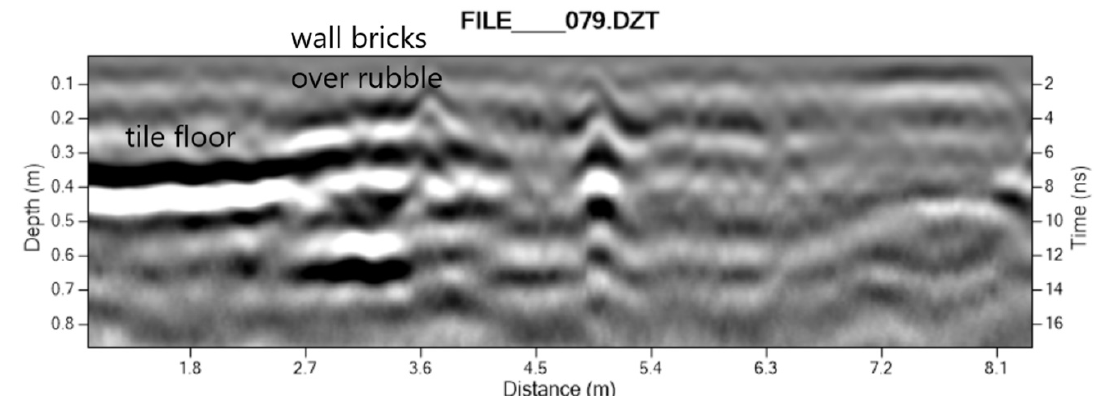
Figure 22. GPR profileshowing Mission Sonoma Building C (tile floor and adobe wall) confirmed through comparisons with 1954 Treganza excavation.